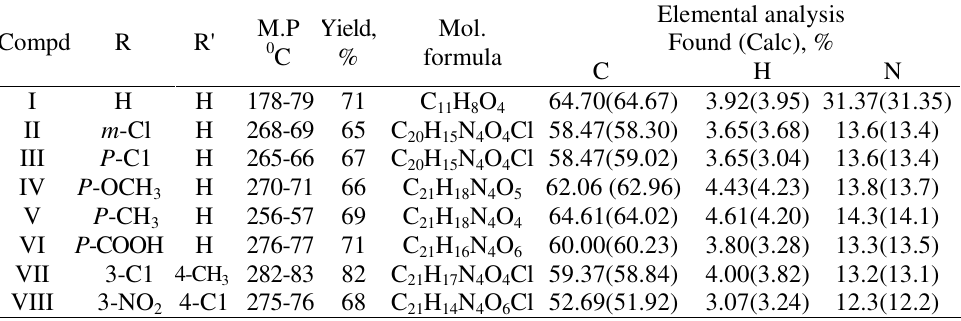
Table 1. Elemental analysis of the